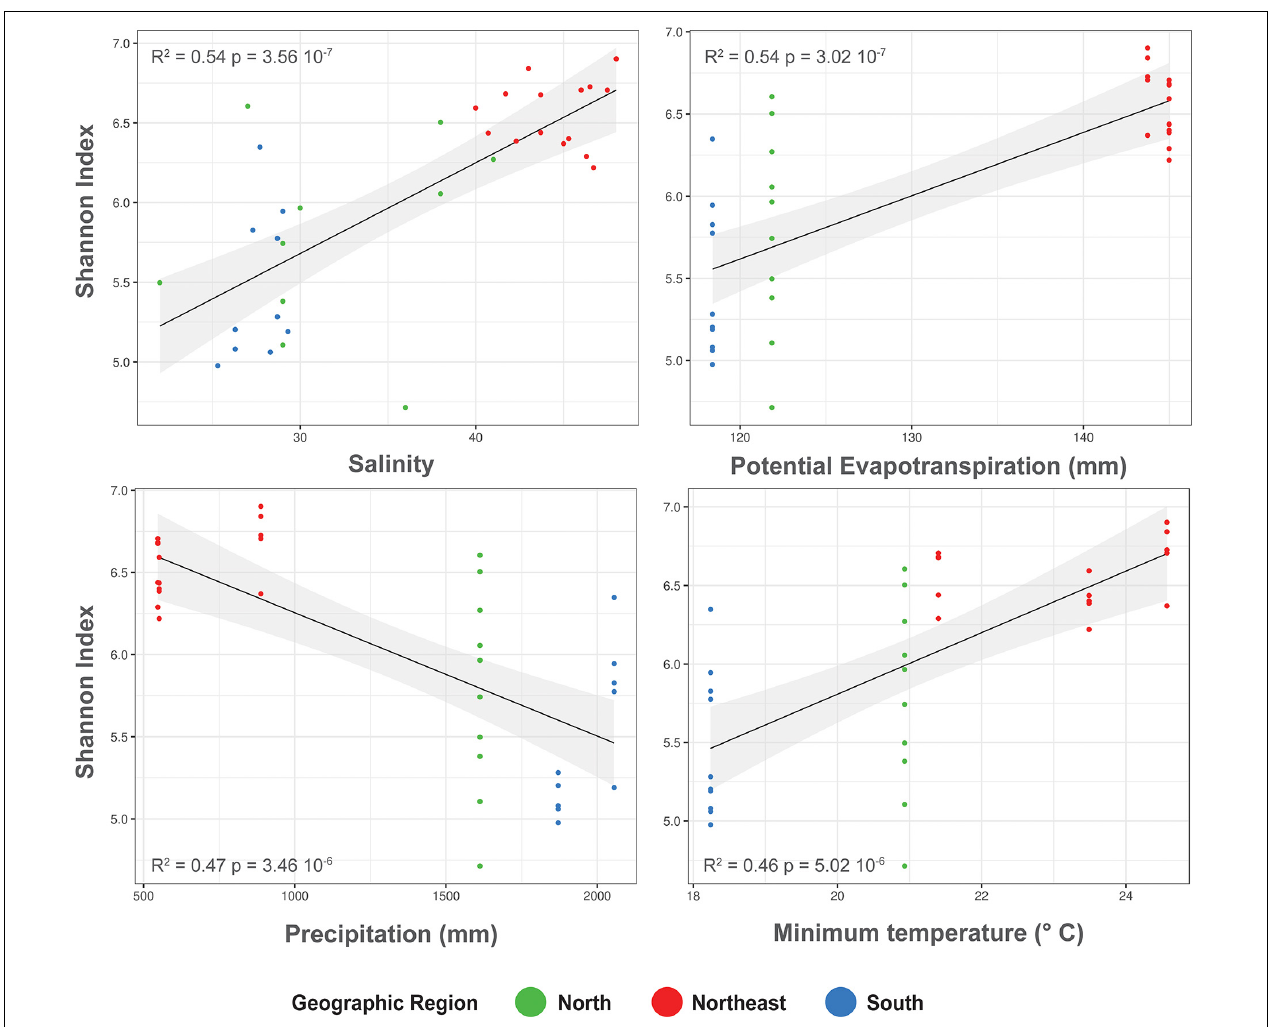
FIGURE 4 | Relationships between Shannon index and Salinity, Potential Evapotranspiration, Precipitation, and Minimum temperature in the Rhizophora mangle root-associated soil microbiomes. The black lines represent linear regressions, and the shaded areas show the 95% confidence interval.